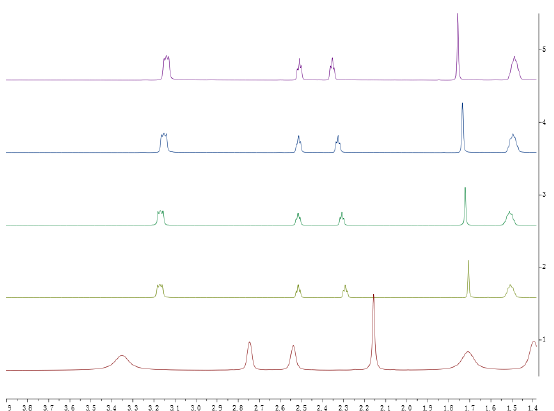
Figure 22. A part of a larger view of Figure 21.